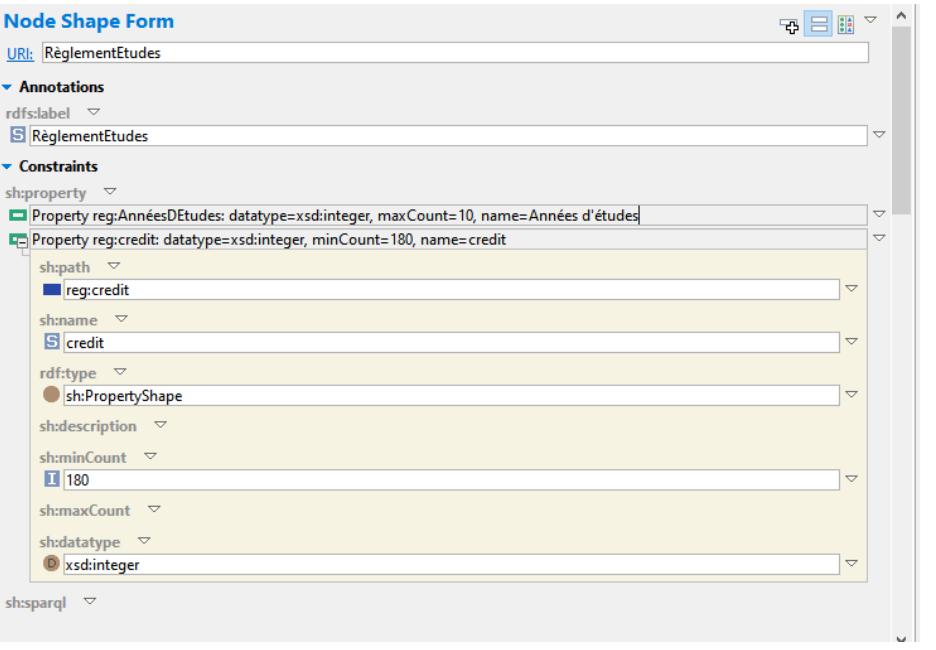
Figure 4: Reasoning - expressing the constraints as rules over the